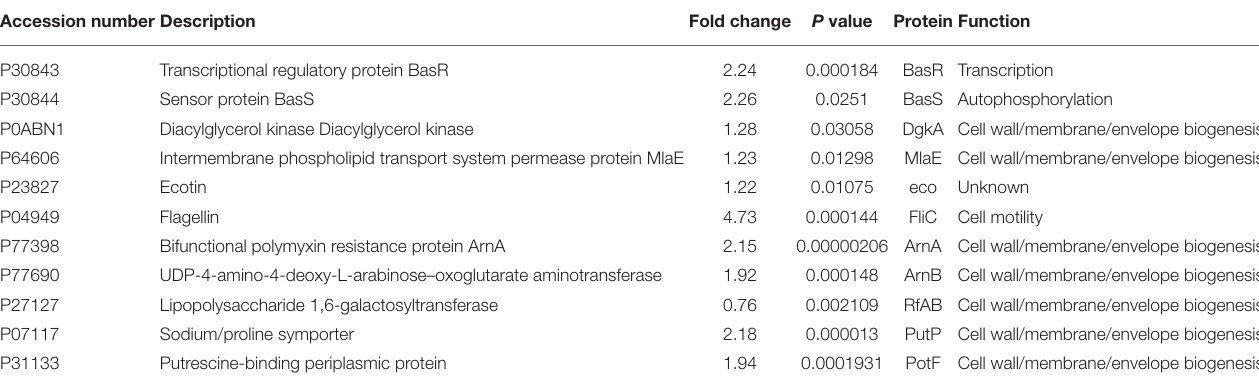
TABLE 6 | BasS/BasR two-component system in E. coli JW0688 regulates protein expression